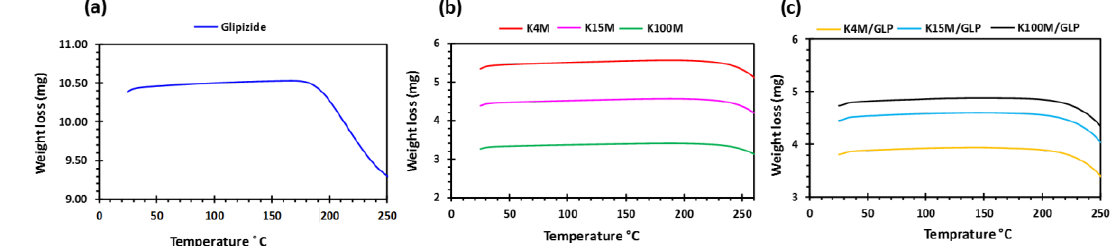
Figure 2. DSC profiles of ( a ) glipizide, ( b ) HPMC (K4M, K15M and K100M) and ( c ) K4M/GLP, K15M/GLP and K100M/GLP filaments.